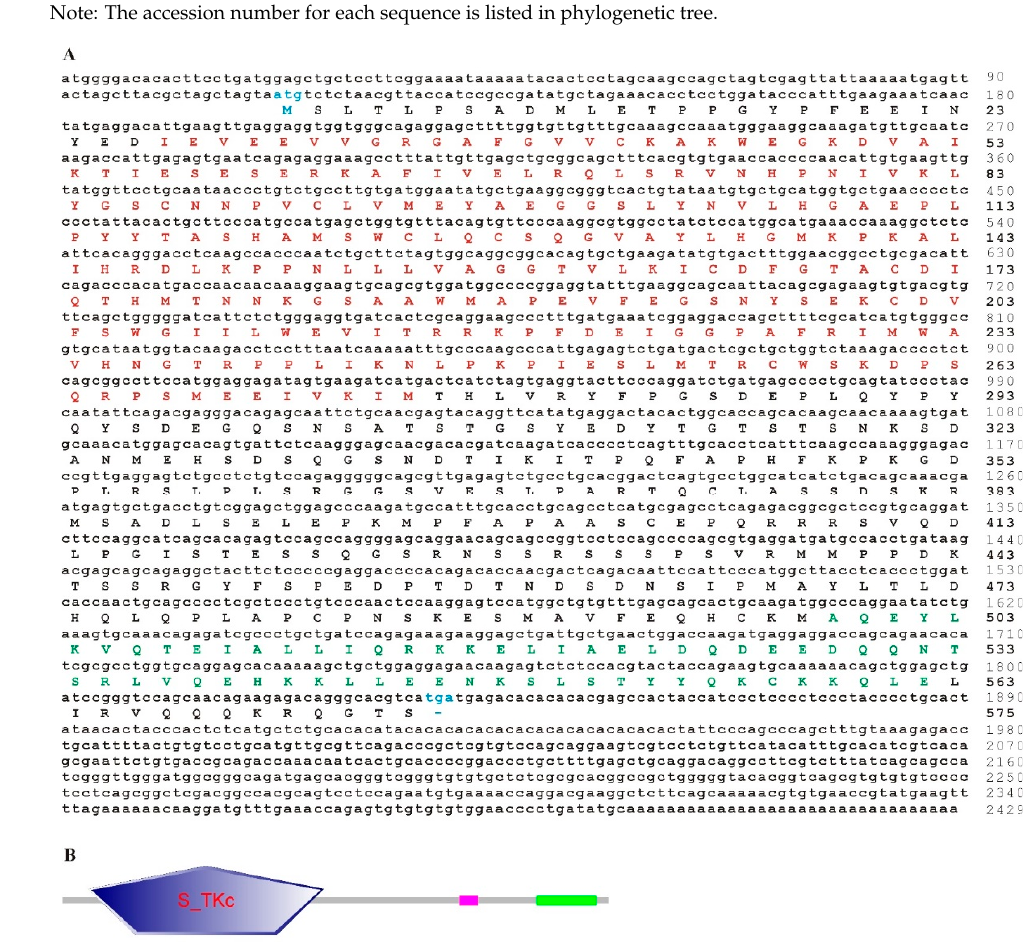
Figure 1. Nucleotide and deduced amino acid sequence of the trTAK1 gene ( A ) and its predicted domains ( B ). The start codon (atg) and stop codon (tga) are marked in cyan. The CCR domain is marked in green, and the S_TKc domain is marked in